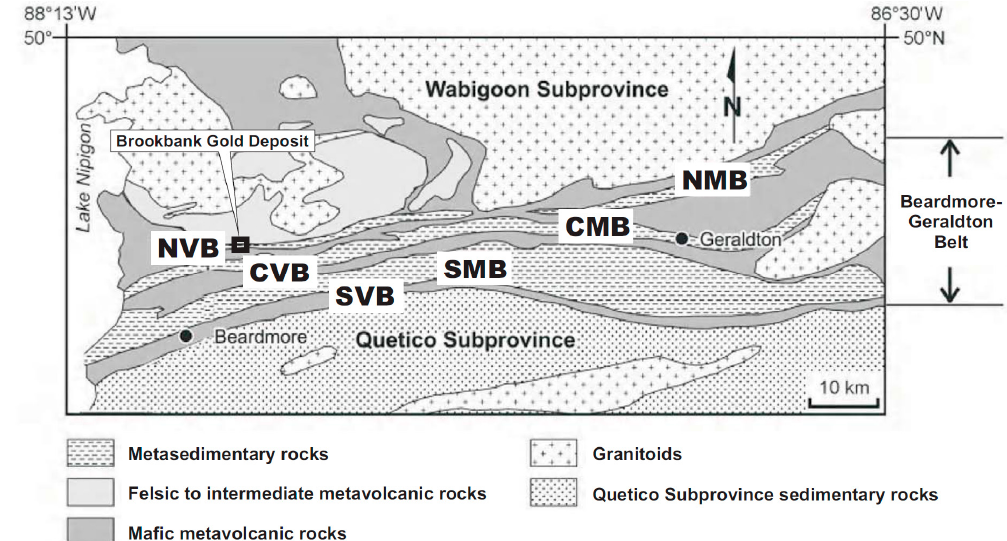
Figure 1. Geology of the Beardmore–Geraldton greenstone belt, with the location of the Brookbank gold deposit. NVB = northern volcanic belt; NMB = northern metasedimentary belt; CVB = central volcanic belt; CMB = central metasedimentary belt; SMB = southern metasedimentary belt; SVB = southern volcanic belt. Modified after [22]. Reproduced with permission from the Ontario Geological Survey, published by the Queen’s Printer for Ontario.